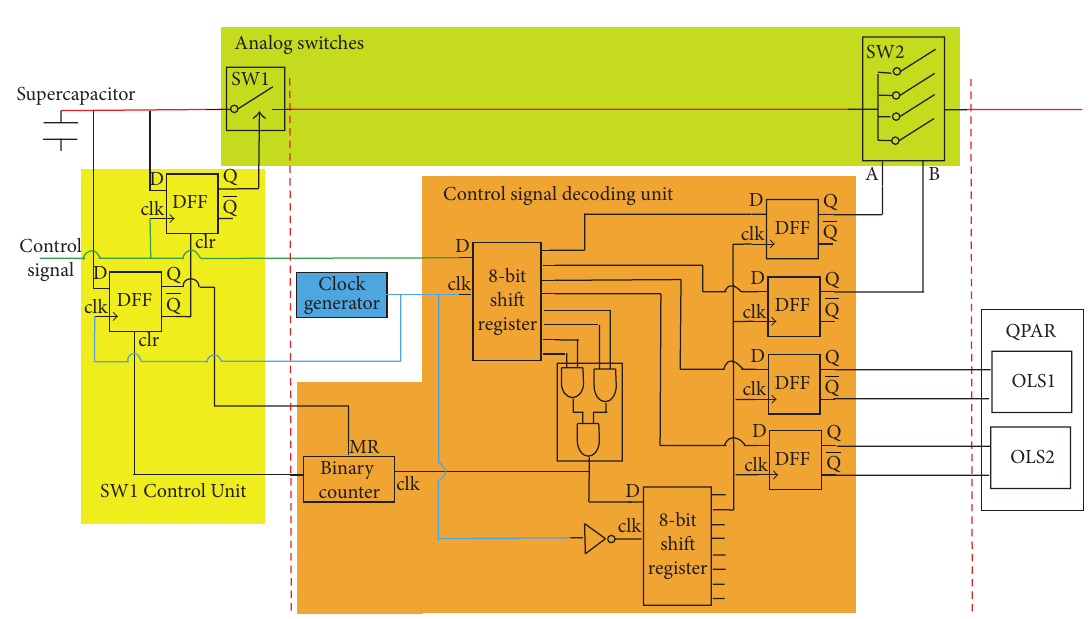
Figure 9: Control circuit